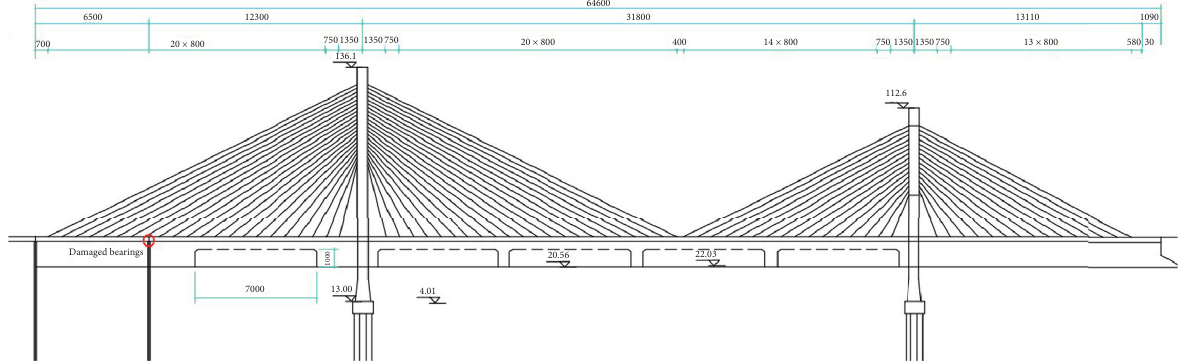
Figure 2: Elevation sketch of Poyanghu Bridge (unit: